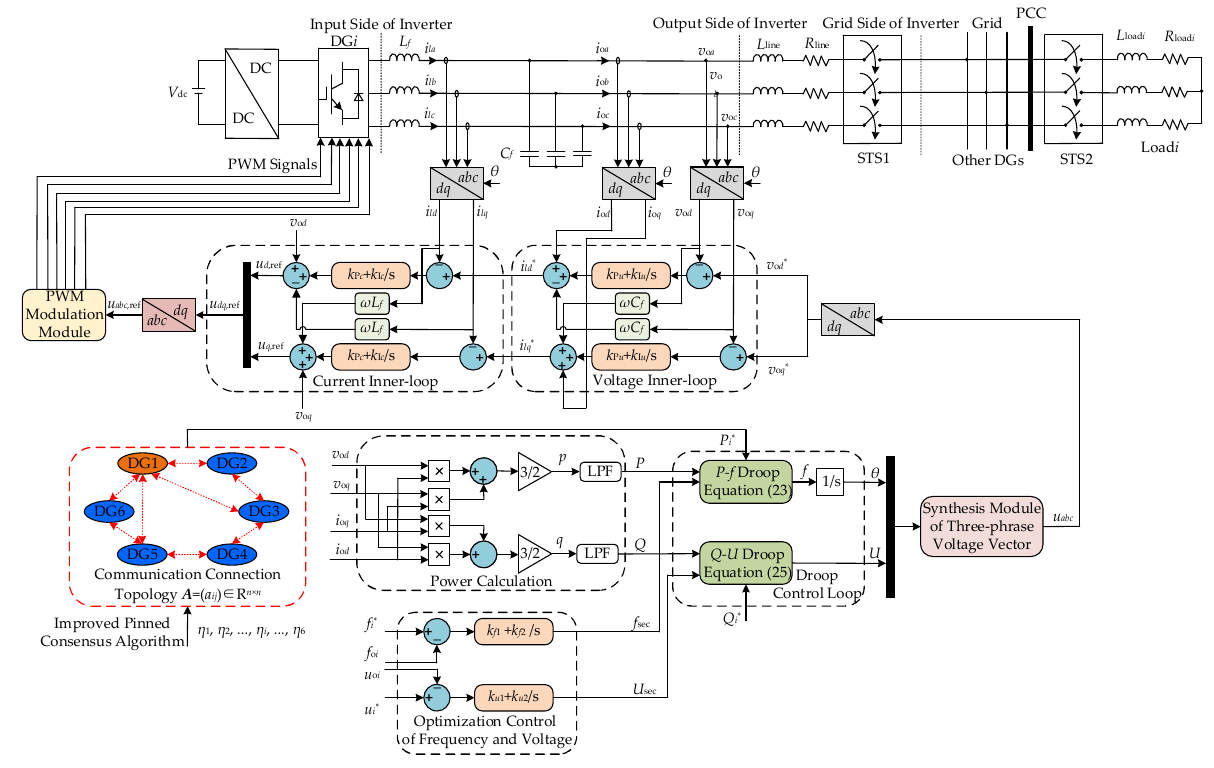
Figure 4. Simulation control framework of DG participating in economic optimization operation. Table 1. Rated active power, power limits, initial active power, filter parameters, control parame- ters, and cost model parameters of each DG.